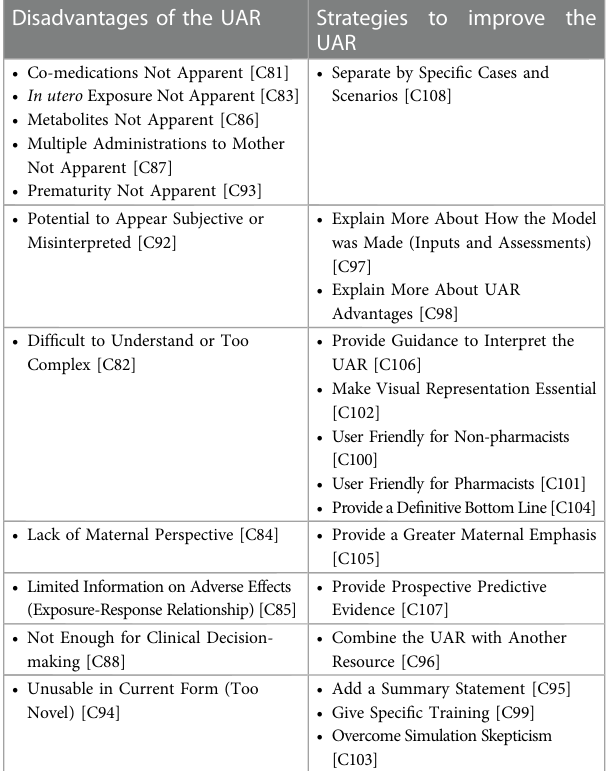
TABLE 3 Codes describing the disadvantages of the UAR and strategies for improvement. Disadvantages of the